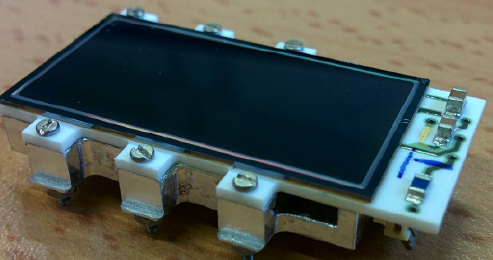
Figure 3. New SDD X-ray detectors for SIDDHARTA2 with a cell area of 64 mm 2 , total area of 512mm 2 . The detectors will be cooled to about 170K and have a drift time of smaller than